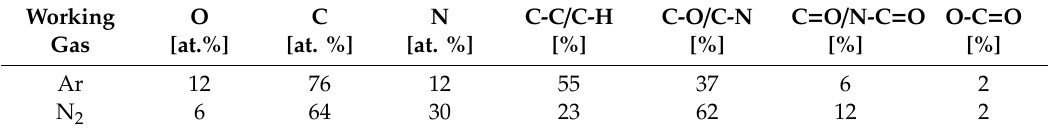
Table 1. Elemental composition of C:H:N:O NPs deposited using Ar or nitrogen and relative